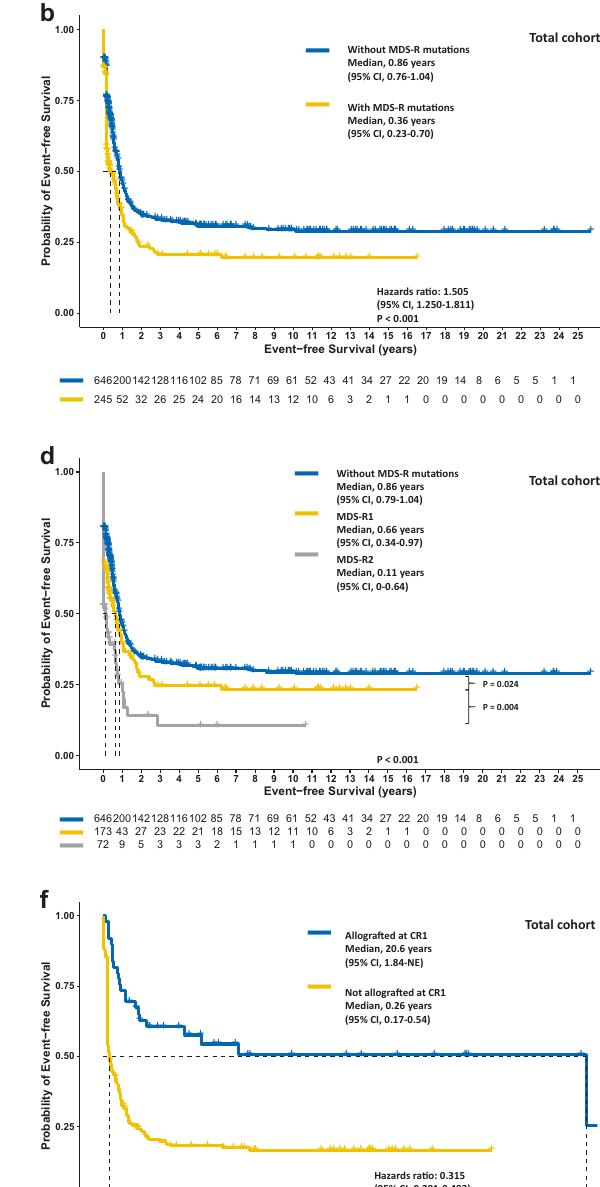
− Without MDS-R muta(cid:2)ons Median, 0.86 years (95% CI, 0.76-1.04) − With MDS-R muta(cid:2)ons Median, 0.36 years (95% CI, 0.23-0.70)